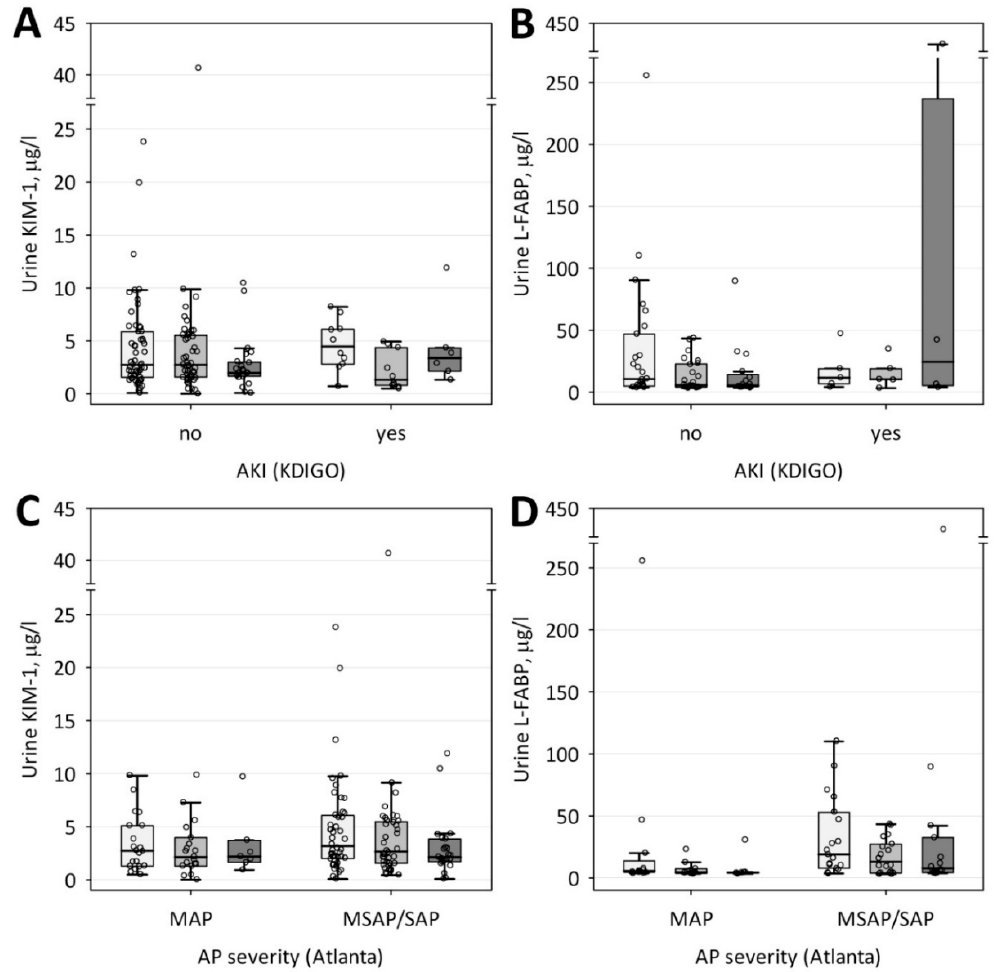
Figure 1. Urinary concentrations of the studied markers of tubular injury: KIM-1 ( A , C ) and L-FABP ( B , D ) among patients with and without acute kidney injury (AKI) ( A , B ) and with mild acute pancreatitis (MAP) in comparison with moderately severe (MSAP) and severe (SAP) disease ( C , D ). Data are shown as median (central line), lower / upper quartile (box), and nonoutlier range (whiskers), circles denote the row data. Light gray boxes denote the concentrations measured on day 1, medium grey on day 2, and dark grey on day 3.